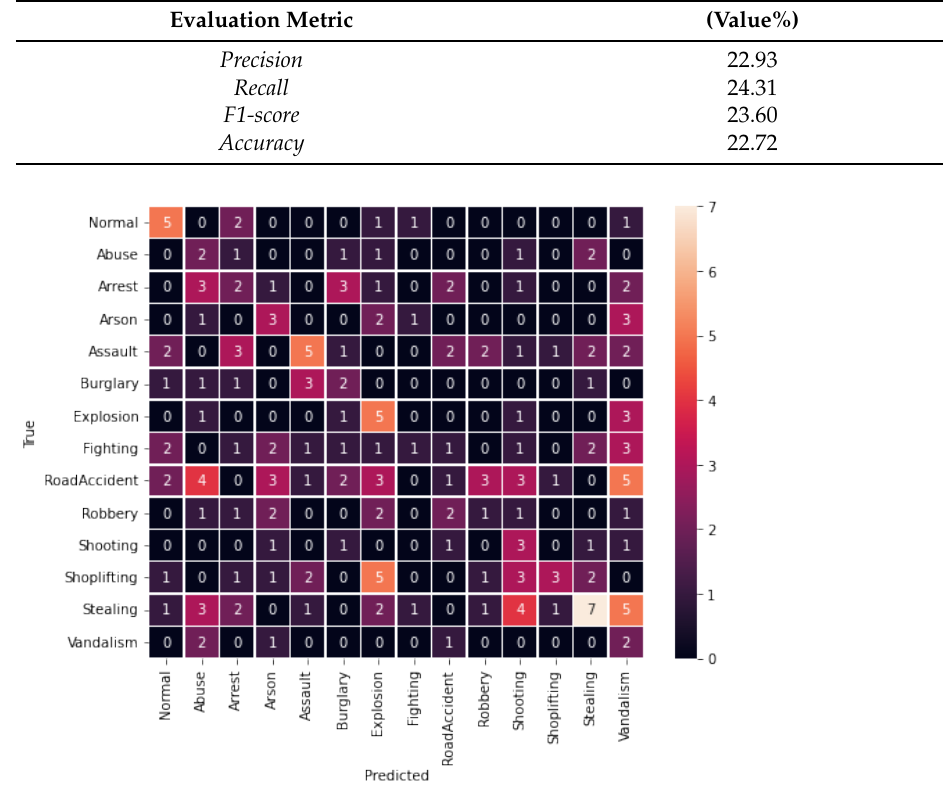
Figure 6. Confusion matrix for 14 categories classification on the UCF-Crime